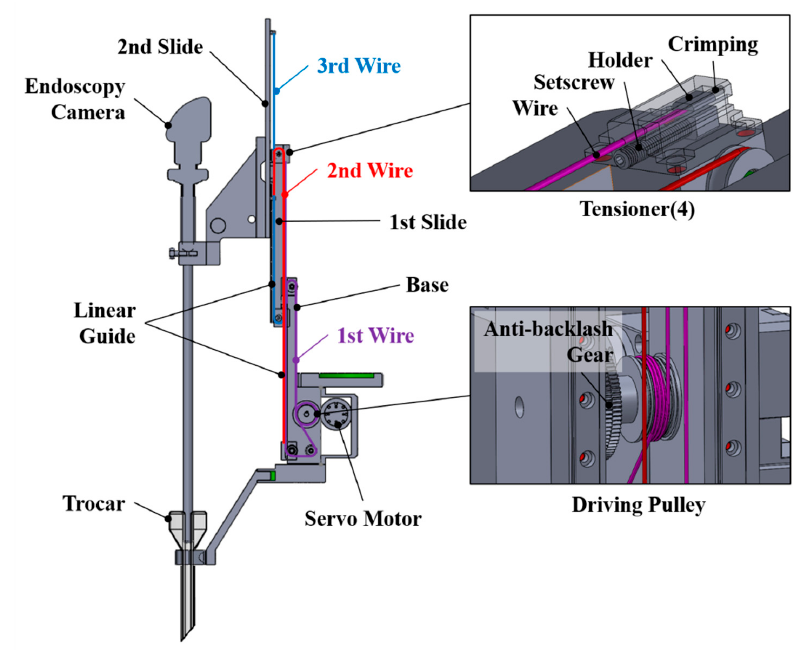
Figure 3. Design of an end effector with a bidirectional telescopic mechanism.